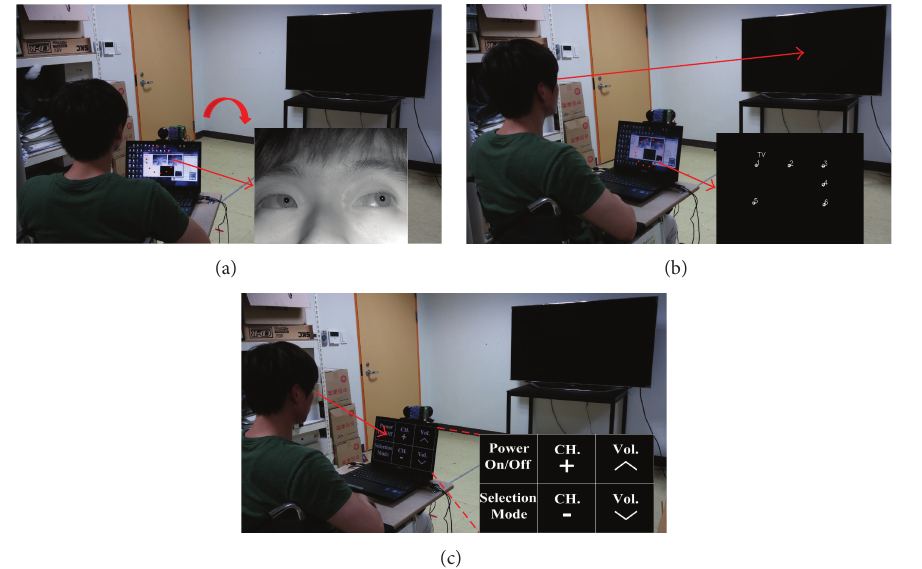
Figure 23: Operation of the proposed system. (a) Navigation mode for moving the wheelchair. (b) Selection mode for determining the home appliance to be controlled. (c) Manipulation mode for controlling the selected home appliance.